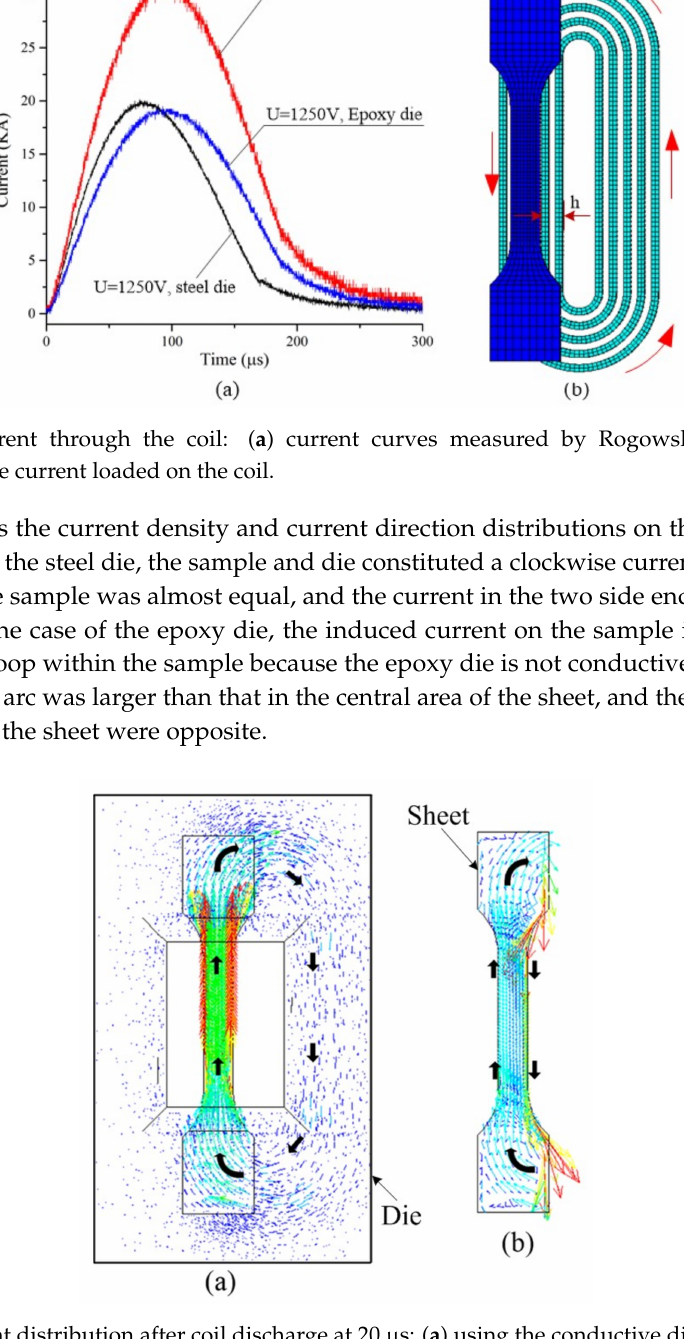
Figure 5. Current distribution after coil discharge at 20 µ s: ( a ) using the conductive die and ( b ) using the nonconductive